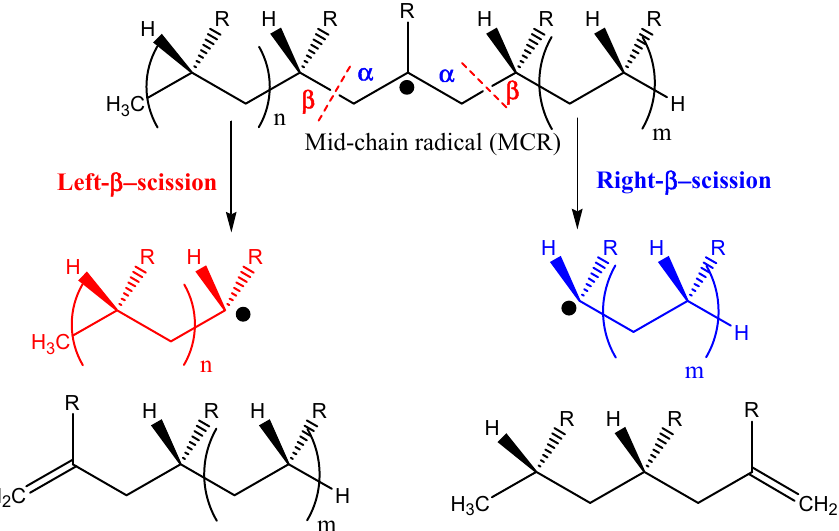
Figure 2. The mid–chain radical mechanism for obtaining low molecular product. Figure 2. The mid-chain radical mechanism for obtaining low molecular product. Table 1. Recent works on pyrolysis of plastic waste over clay